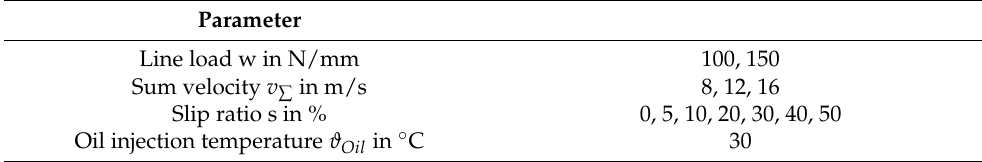
Table 3. Considered operating conditions.